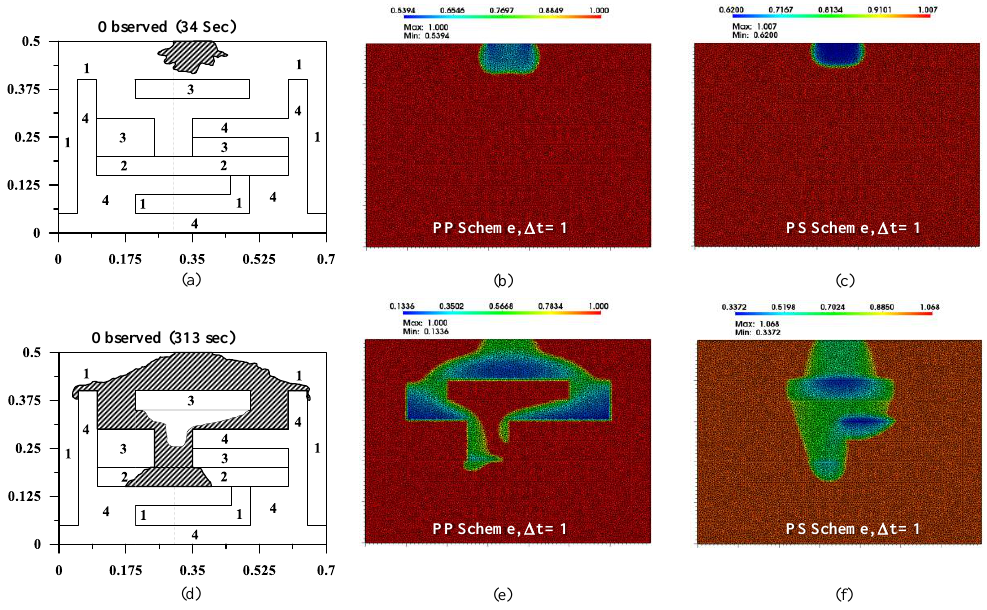
Figure 8. Comparison of observed (redrawn) and predicted tetrachloroethylene distribution in terms of the liquid at 34 s ( a – c ) and 313 s ( d – f ). Table 3. Fluid properties.